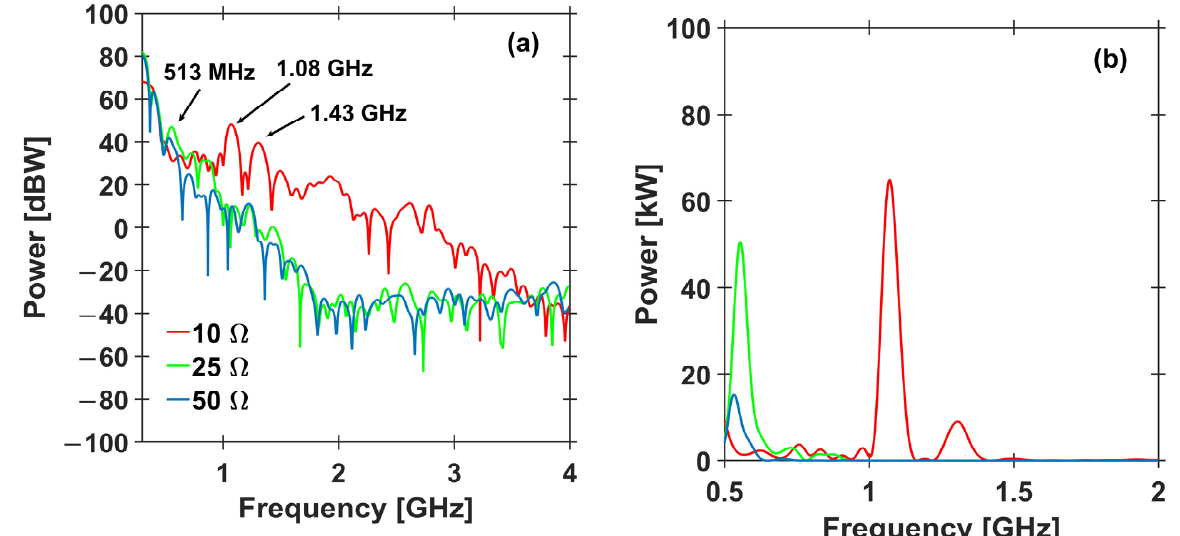
Figure 4. Measured output spectrum for 10, 25, and 50 Ω NLTLs at 20 kV charging voltages given in ( a ) logarithmic and ( b ) linear power.